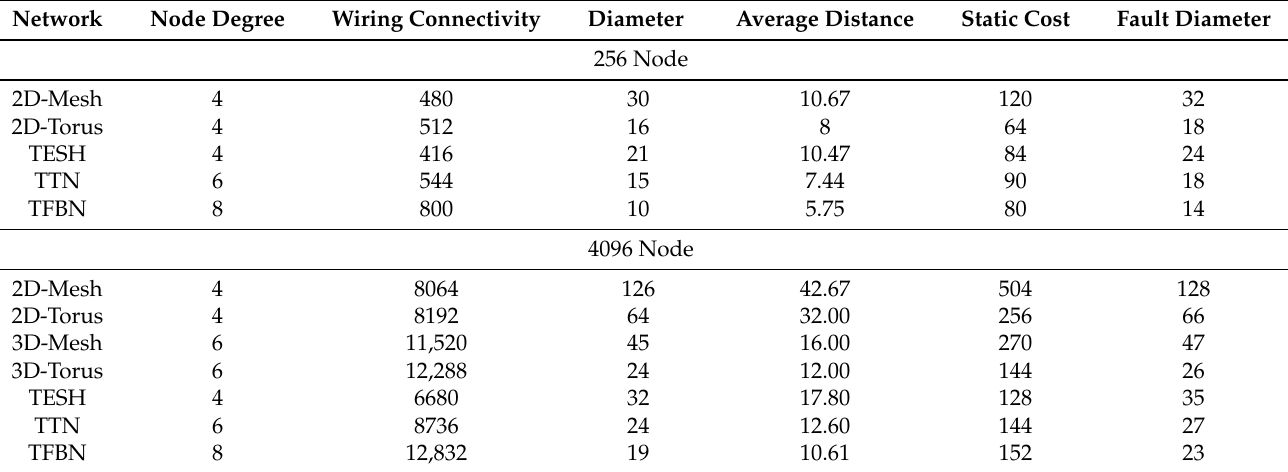
Table 1. A comparison of the static network performance of various